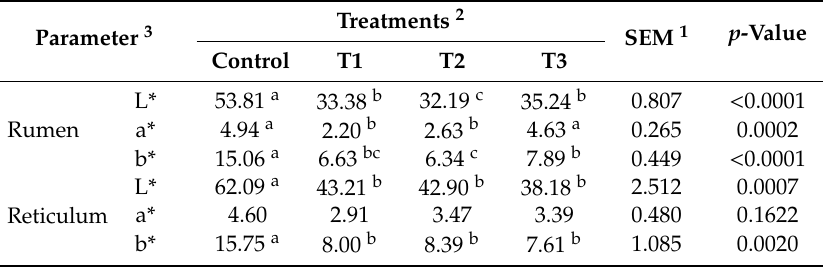
Table 4. E ff ect of treatments on the color of rumen and reticulum of the growing Naemi lambs (the end of the